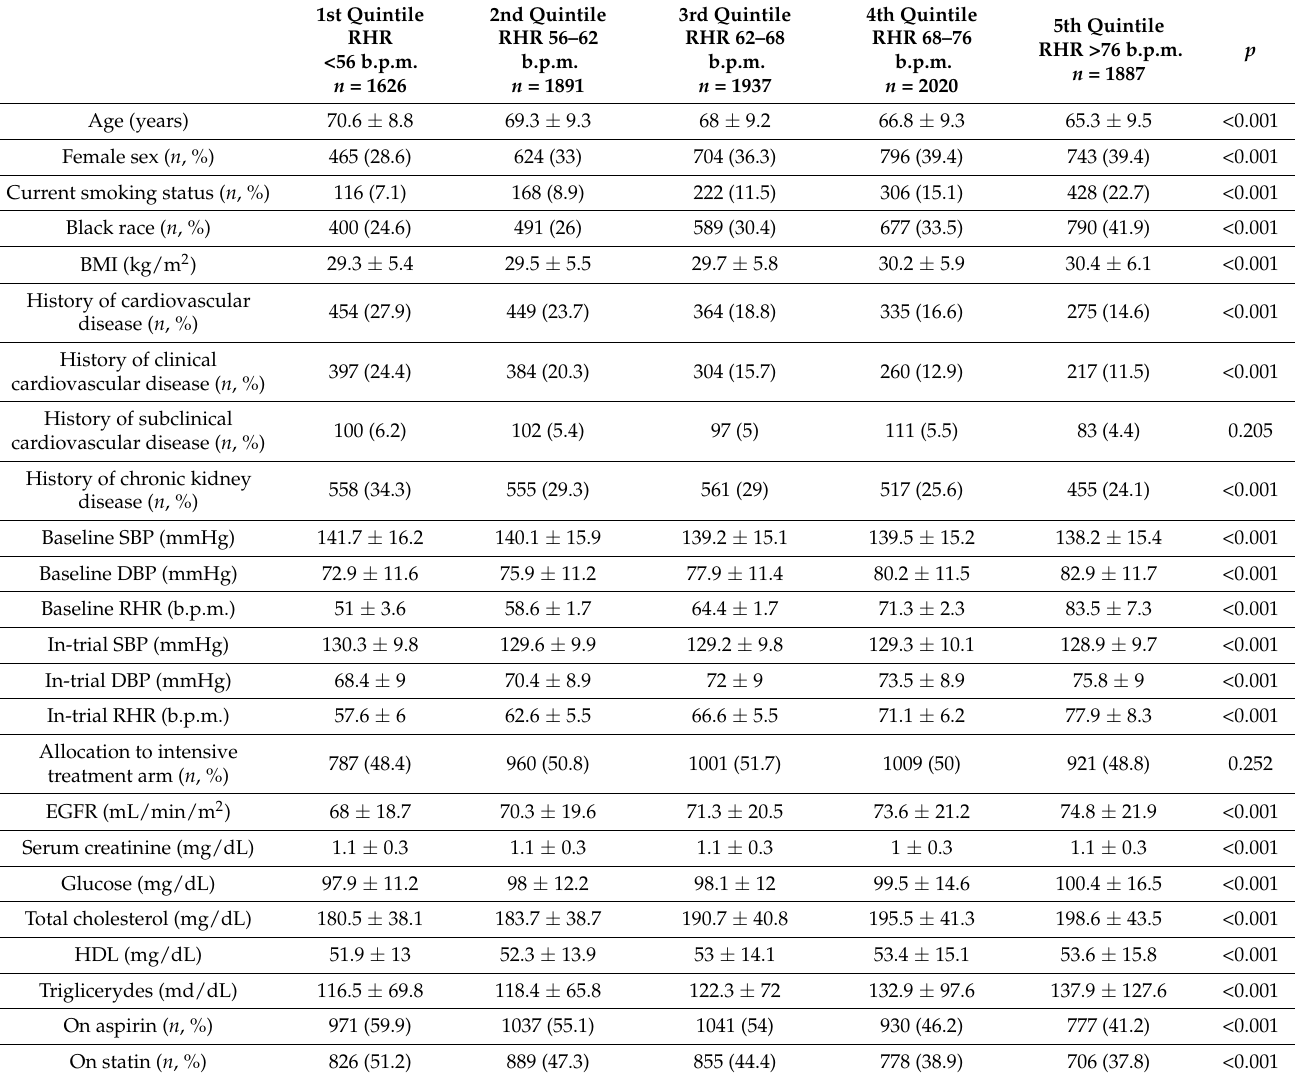
Table 1. Characteristic study population according to baseline resting heart rate